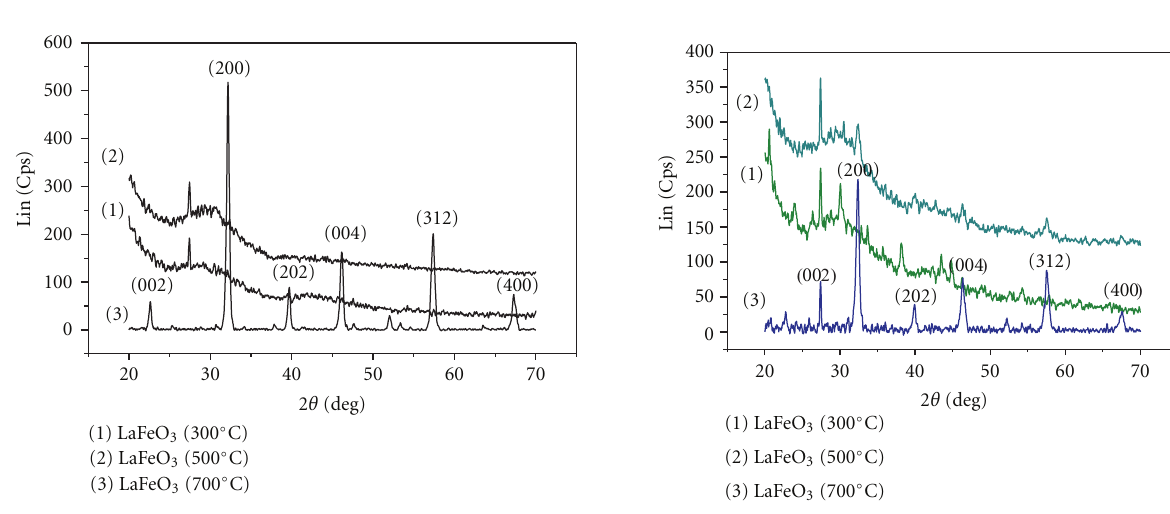
Figure 6: The powder X-ray di ff raction patterns of hydroxide gel heated at 300 ◦ C (line 1); 500 ◦ C (line 2); 700 ◦ C (line 3) for 3